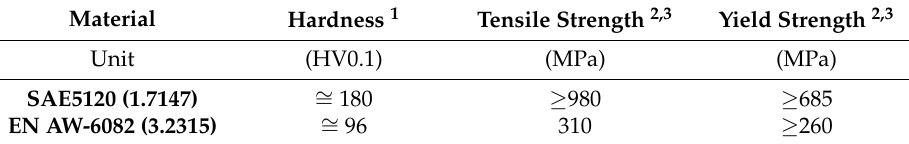
Table 2. Material properties.